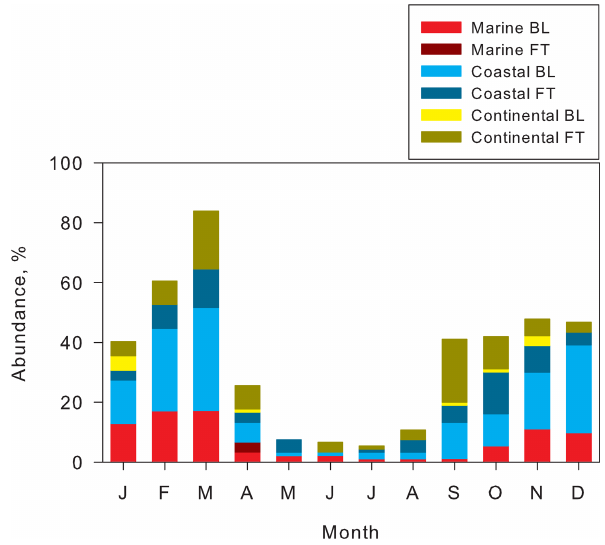
Figure 6. Seasonal features of abundance of tri-modal and quad- modal structures and air mass origins at Syowa Station, Antarctica, in